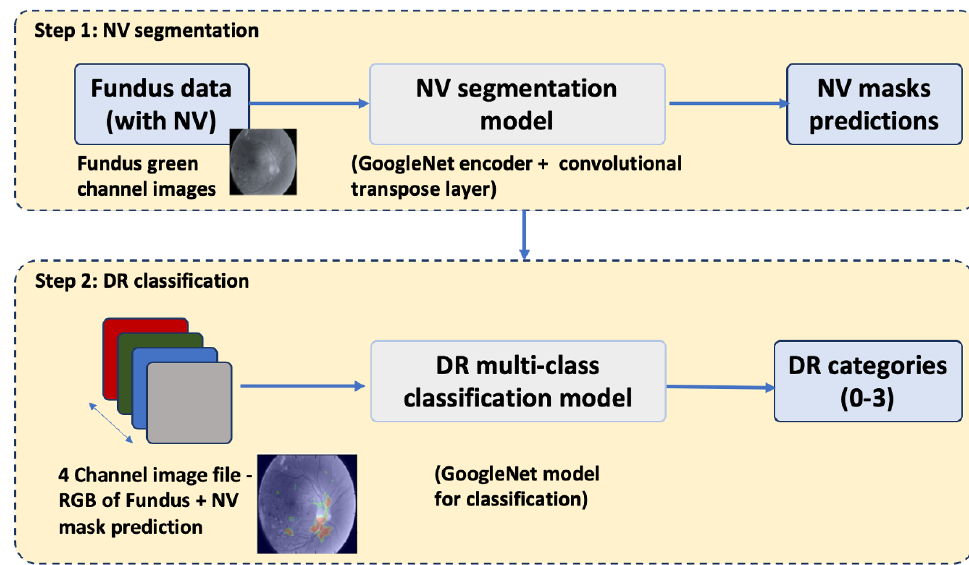
Figure 2. Steps of the segmentation-assisted DR classification algorithm. NV: neovascularization; DR: diabetic retinopathy.